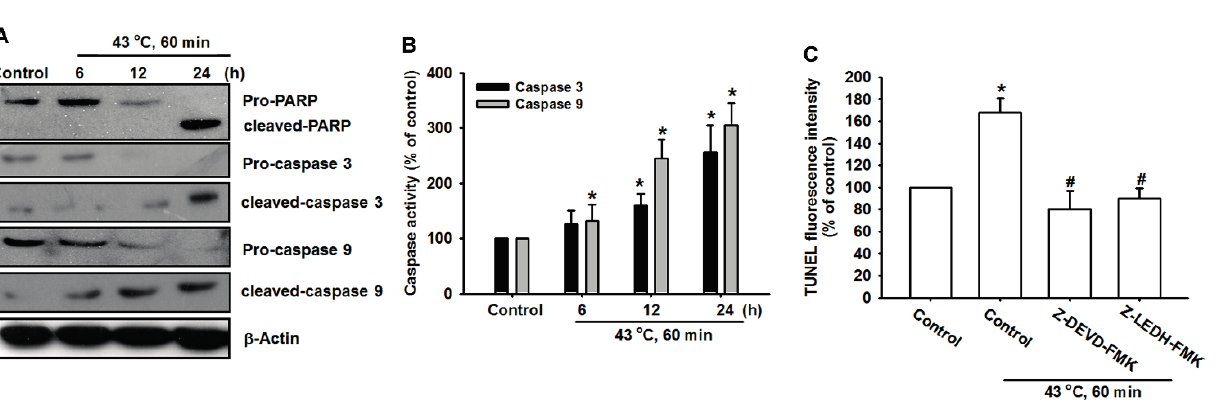
Figure 5. Hyperthermia induces caspase activation in human OS cells. ( A ) U-2 OS cells were incubated with hyperthermia (43 °C, 60 min) for different time intervals, PARP, caspase 3 and caspase 9 expressions were examined using Western blot analysis; ( B ) U-2 OS cells were incubated with hyperthermia (43 °C, 60 min). After 24 h, caspase 3 and caspase 9 activities were examined using a caspase ELISA kit; ( C ) U-2 OS cells were pretreated for 1 h with z-DEVD-FMK (caspase 3 inhibitor) or z-LEHD-FMK (caspase 9 inhibitor), followed by stimulation with hyperthermia (43 °C, 60 min. After 24 h, the percentage of apoptotic cells was then analyzed by conducting flow cytometric analysis on a TUNEL assay. The results are expressed as the mean ± SEM * , p < 0.05 compared with the control. #, p < 0.05 compared with the hyperthermia-treated